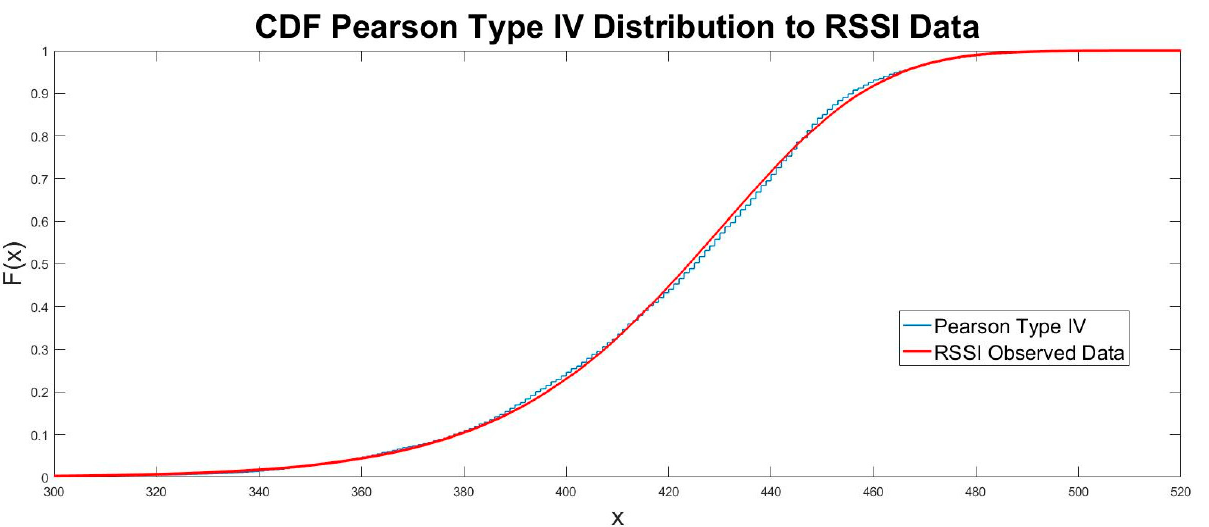
Figure 8. The cumulative distribution function for Pearson Type IV against RSSI data.